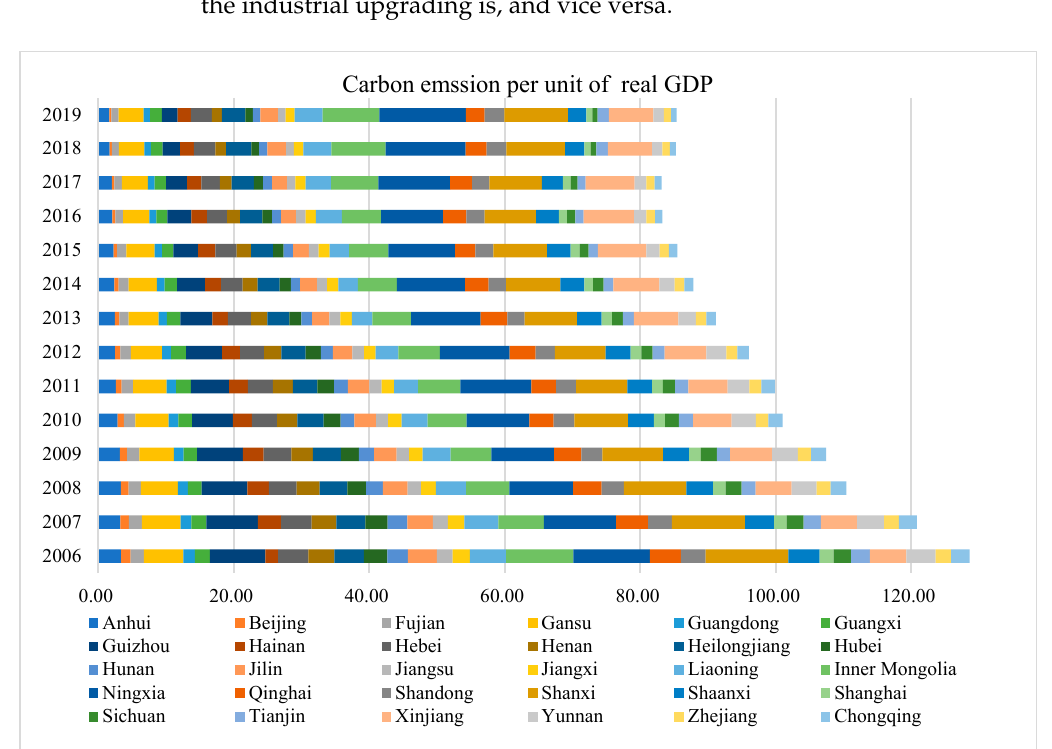
Figure 2. Provincial carbon intensity from 2006 to 2019.